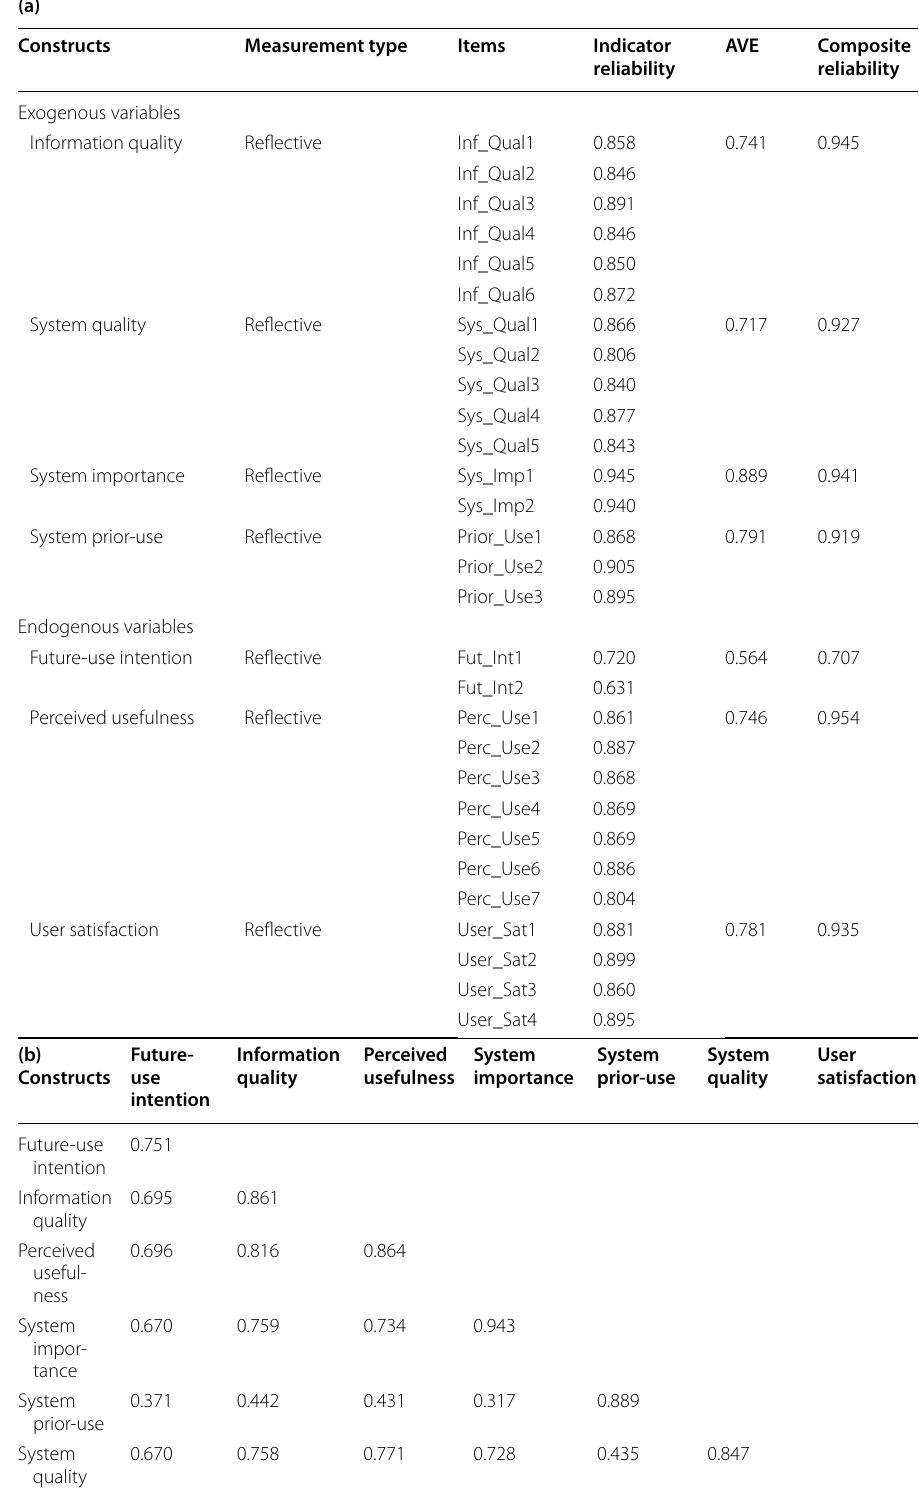
Table 1 a and b Measurement models, quality testing and discriminant validity